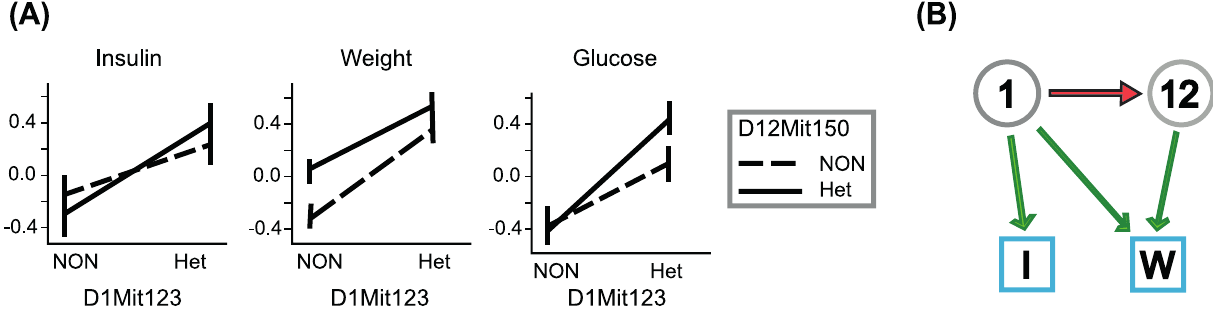
Figure 3. R/cape-derived interaction between Chromosome 1 and Chromosome 12. (A) R/cape effect plots showing normalized phenotype values for each combination of the Chromosome 1 (D1Mit123) and Chromosome 12 (D12Mit150) genotypes. NON denotes a homozygous locus and Het denotes an NON/NZO heterozygote. Positive slopes correspond to Chromosome 1 effects, while differences between solid and dashed lines represent the Chromosome 12 effects. Positive and significant weight effects were detected for both loci, whereas effects on insulin were only significant for the Chromosome 1 marker. Neither locus had a significant effect on serum glucose. Significant epistasis was detected for weight, and appears as the convergence of solid and dashed lines for heterozygosity at the Chromosome 1 locus. Note that plotted data are not conditioned on maternal obesity, which was a covariate in the analysis. (B) Interaction network for variants on Chromosomes 1 and 12, extracted from Figure 2C, showing the significant suppressive interaction (red arrow) from the Chromosome 1 variant to the Chromosome 12 variant (gray circular nodes). Significant main effects (green arrows) link the source variants with the target phenotypes weight and insulin (square nodes labeled ‘‘I’’ and ‘‘W’’ respectively).